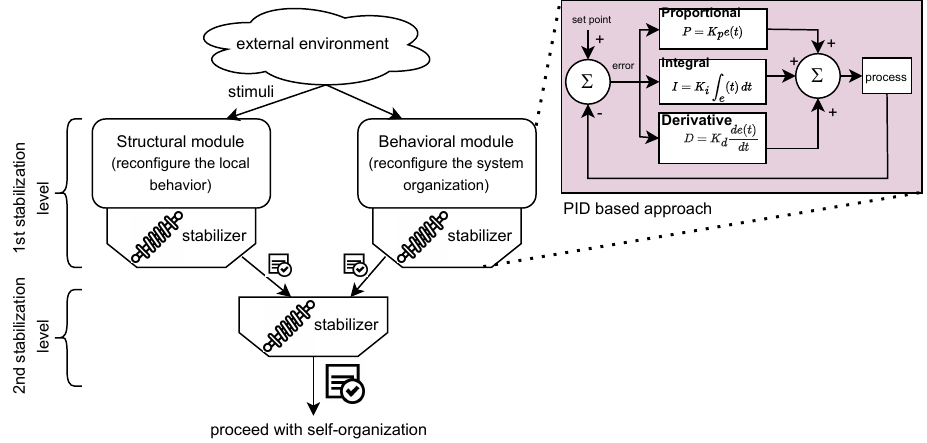
Figure 13. PID–based stabilizers to manage the nervousness in self-organized